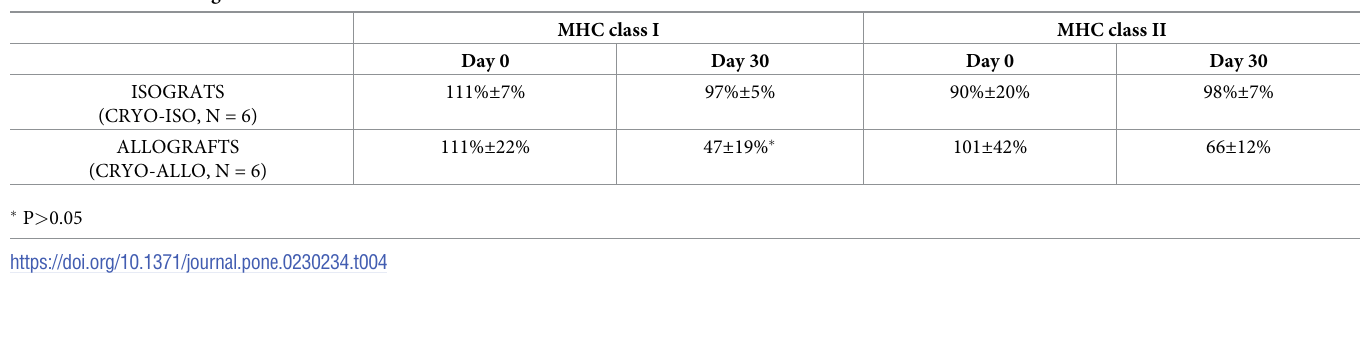
Table 4. Percentage of fluorescence-labelled MHC class I and MHC class II antibody binding to Brown-Norway splenocyte in the presence of sera of Lewis recipi- ents of aortal iso- or allografts.